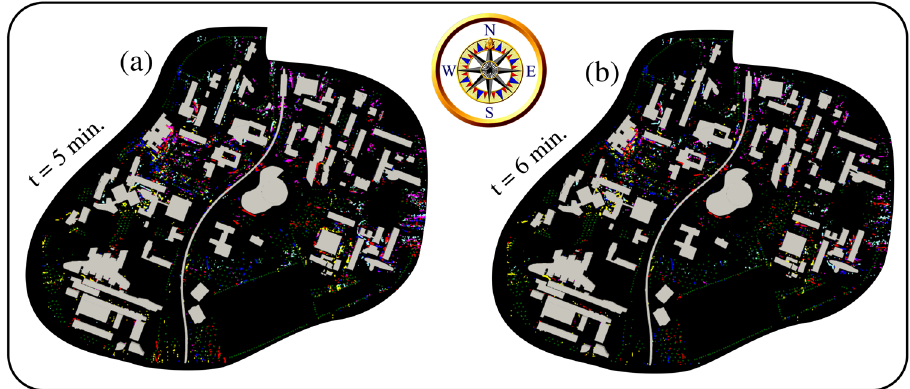
Figure 8. Risk assessment maps obtained from advanced large-scale computational fluid dynamics simulations, including the trees in green colour (initial sources of pollen emission). Pollen allergy zones inside a university campus. The five different colours correspond to pollen grains between 0.5 and 2.5 m above the ground level (a dangerous height interval where people stand and are more exposed). Yellow: 06/04/2020; red: 07/04/2020;